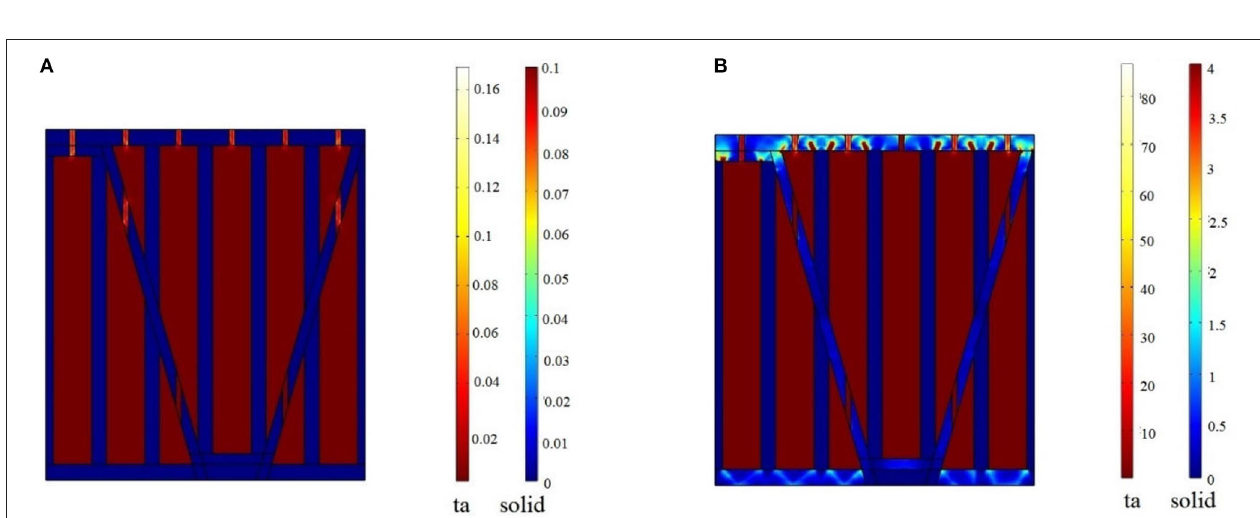
FIGURE 8 | Energy dissipation distribution at 500Hz. (A) All-aluminum structure; (B) Composite structure. ta and solid stand for thermoviscous acoustics area and solid mechanics area. The unit is W/m 3